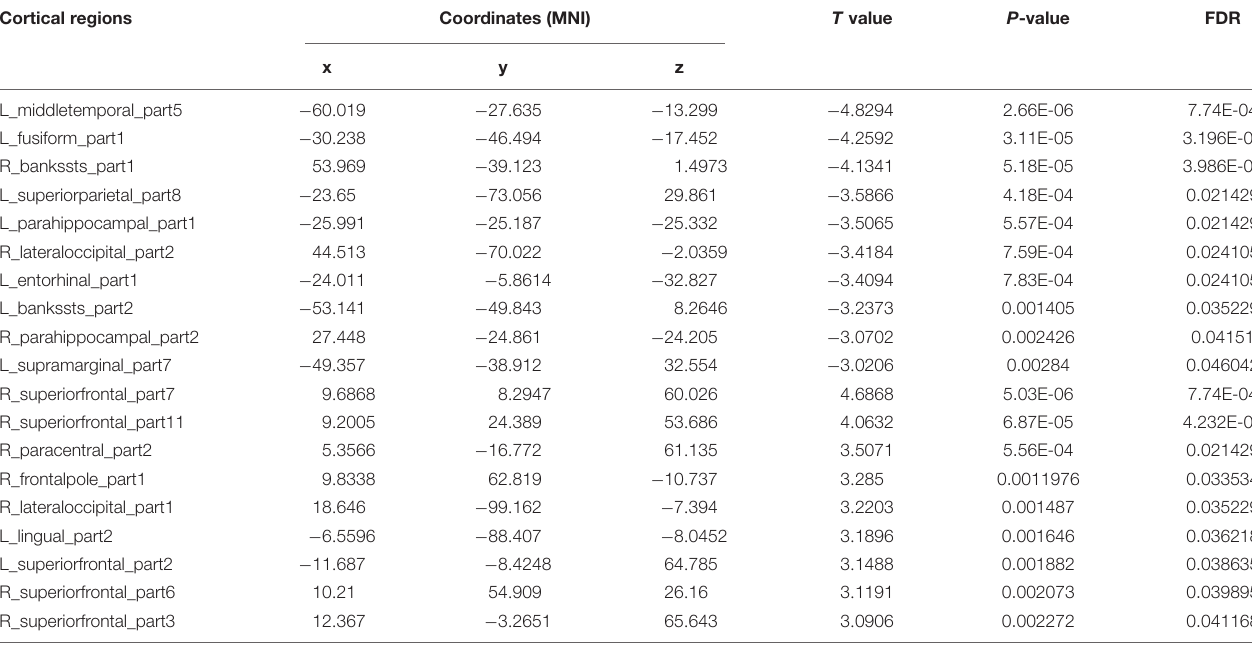
TABLE 2 | Cortical regions of case-control differences in regional morphometric similarity. Cortical regions Coordinates (MNI)